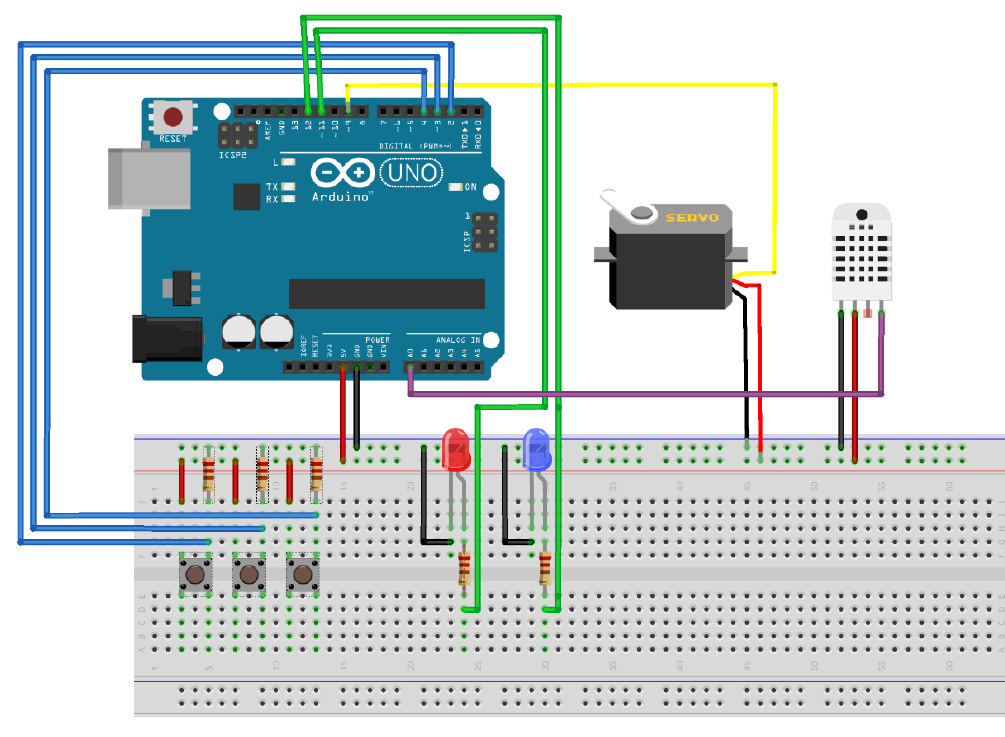
Figure 11. Scheme of laboratory car wiper